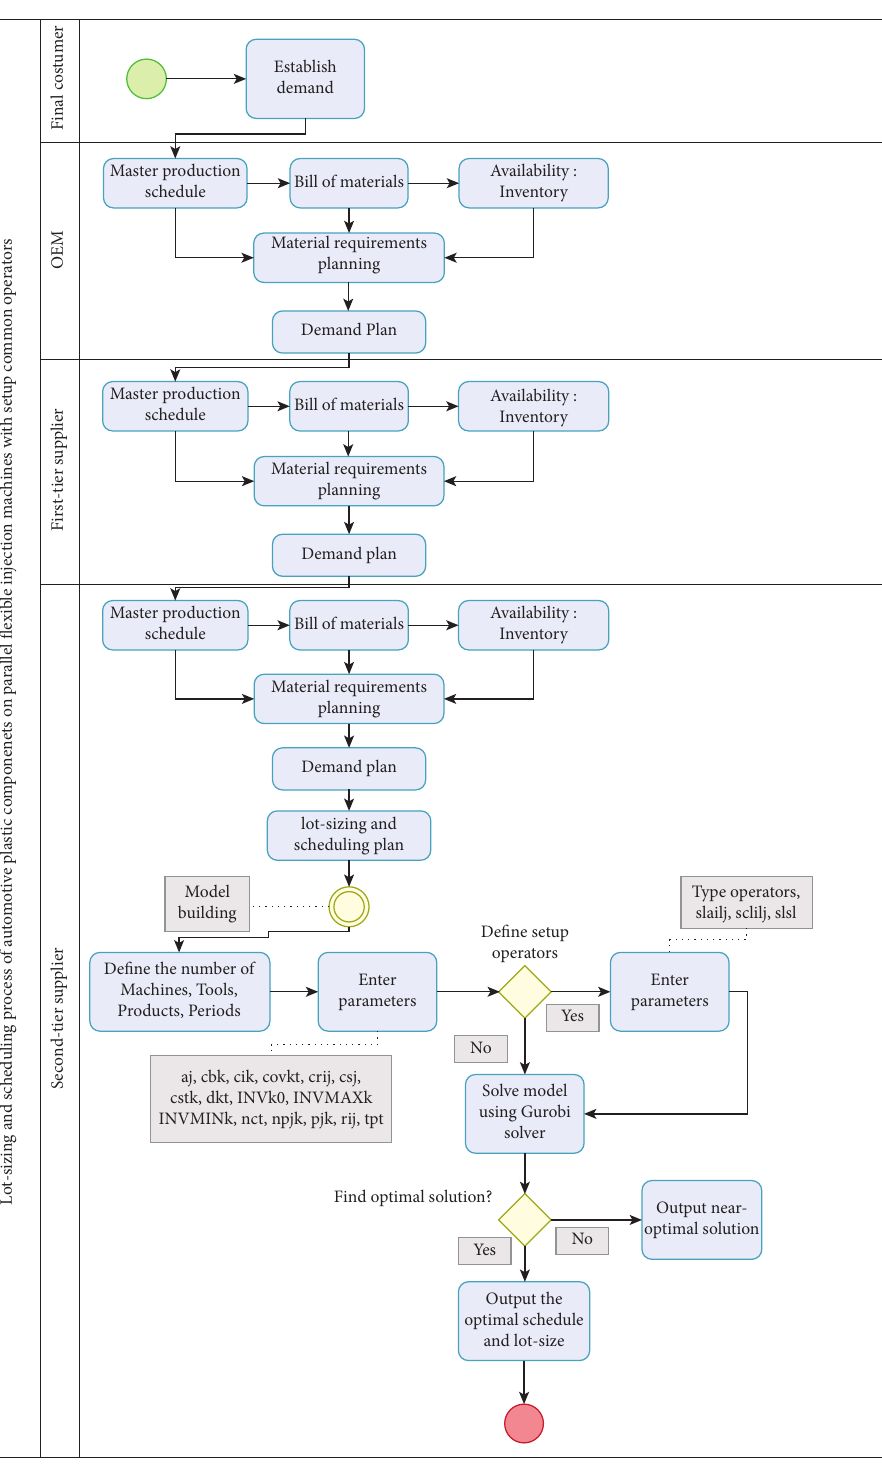
Figure 2: Flowchart of the proposed solution